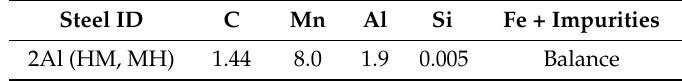
Table 1. Chemical composition of the steel used in the present study (mass